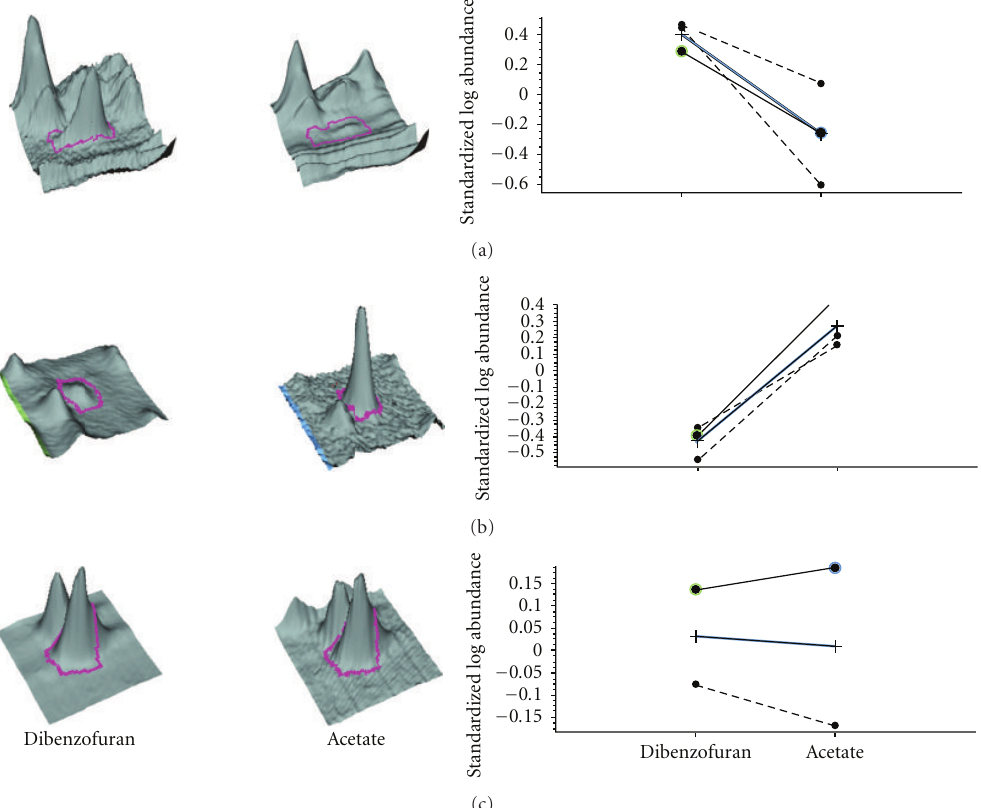
Figure 2: Statistics and spot information for three representative spots from DIGE analysis of the RW1 crude cell proteome. Following visual examination of the spot characteristics and matching parameters, spots were identified as increased ((a), gi | 148555952 glyoxalase/bleomycin resistance protein/dioxygenase), decreased ((b), unidentified protein), or unchanged ((c), gi | 148553776 OmpA/MotB domain protein).